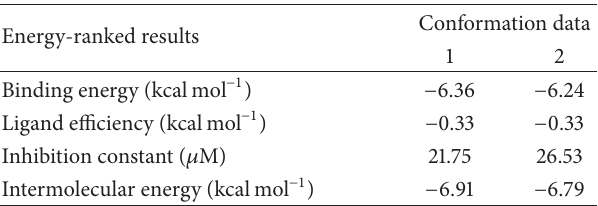
Table 3: The lowest energy-ranked results of two liquiritigenin- HAase binding